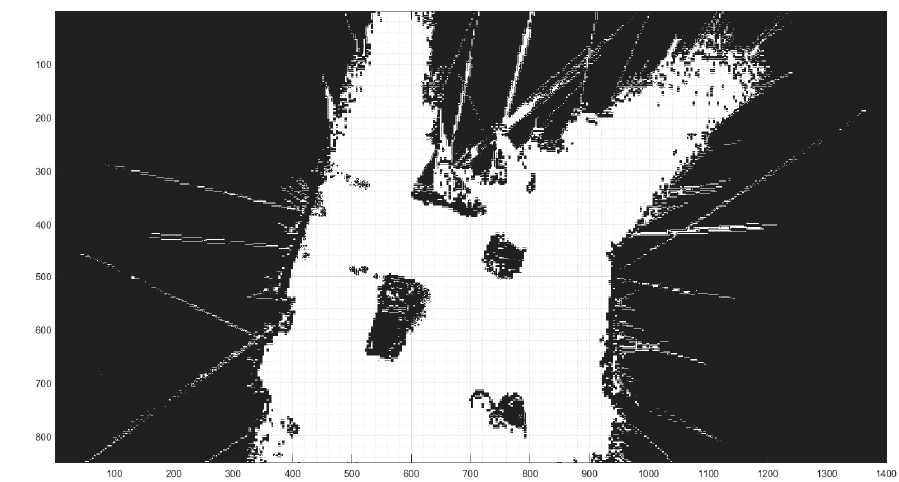
Figure 16. Mobile platform for experiments.